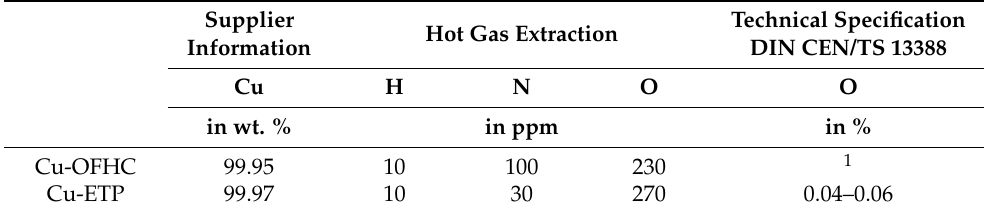
Table 2. Cu content provided by the suppliers and H, N, O content of Cu-OFHC and Cu-ETP powder measured with hot carrier gas